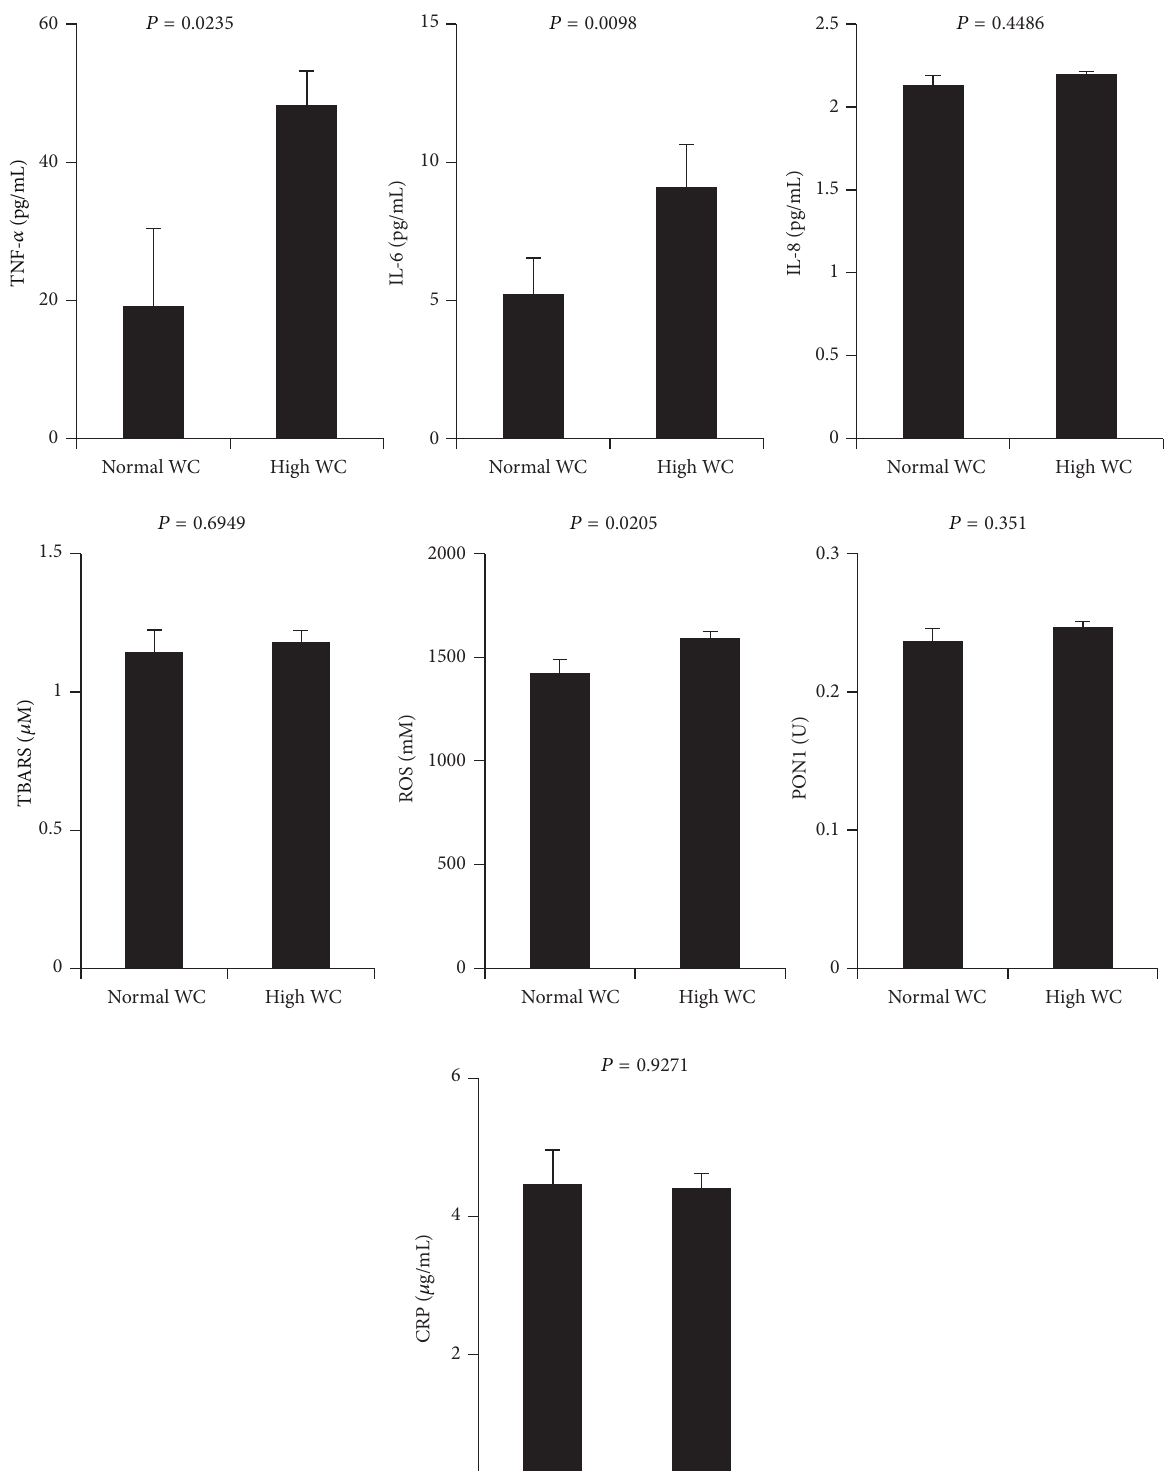
Figure 2: Least square of TNF- 𝛼 , Il-6, IL-8, CRP, TBARs, ROS, and PON1 concentrations in plasma, for all subjects after adjusting for age, BMI, and